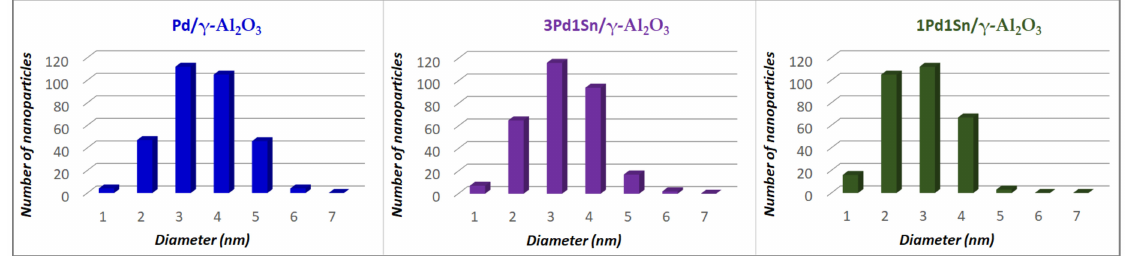
Figure 2. Nanoparticle size histograms for Pd/ γ -Al 2 O 3 (blue, left ); 3Pd1Sn/ γ -Al 2 O 3 (violet, center ) and 1Pd1Sn/ γ -Al 2 O 3 (green, right ).